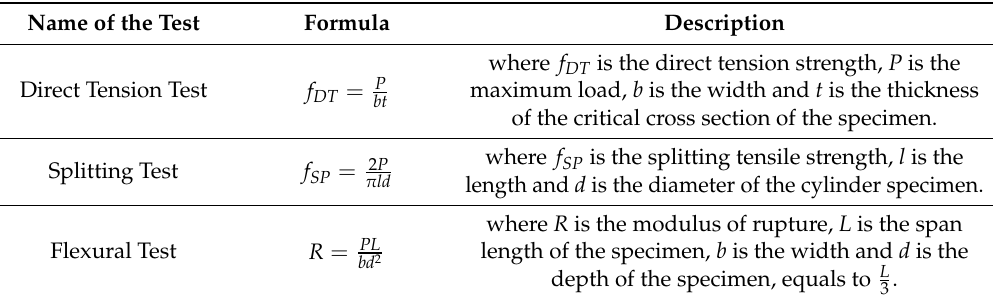
Table 4. Tensile strength formulas [27].